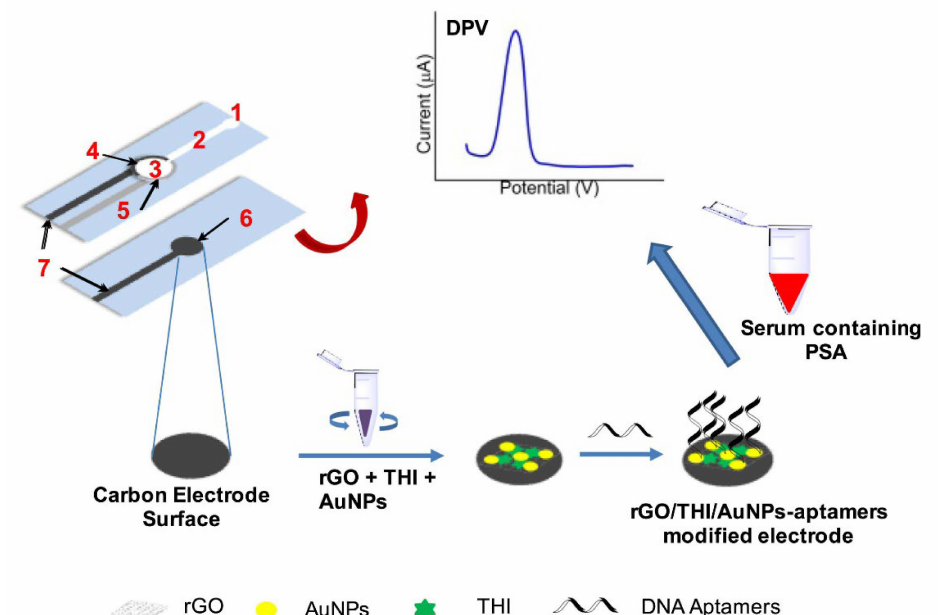
Figure 8. Diagram showing the fabrication and analysis steps of the microfluidic paper-based aptasensor device. (1) Injection site, (2) microfluidic channel, (3) reaction zone, (4) screen-printed carbon counter electrode, (5) screen-printed reference electrodes, (6) screen-printed working electrode; (7) the tip of the screen-printed electrode. Reprinted with permission from Ref. [94]. Copyright 2018,